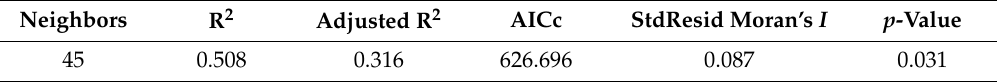
Figure 6. The standardized value of prediction. Table 2. Summary and descriptive statistics of geographically weighted regression